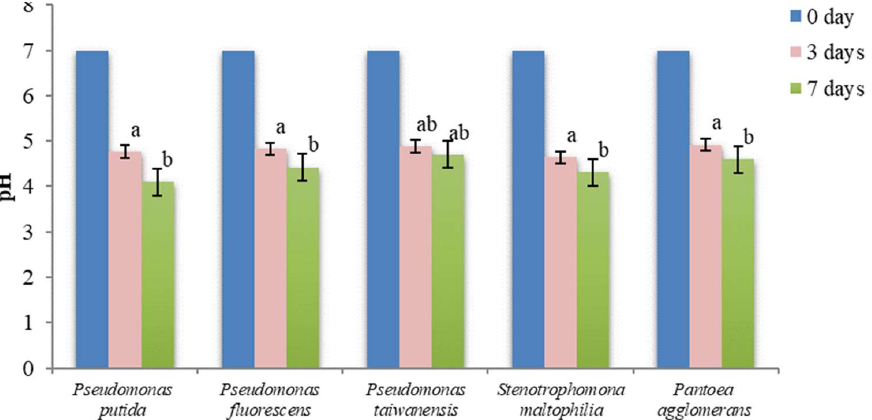
Figure 4. Variation of pH in NBRIP culture medium. Vertical bars represent confidence intervals at a confidence level of 95% (n = 3). Same letters indicate that differences among the means is not statistically significant (Tukey’s HSD post hoc test).